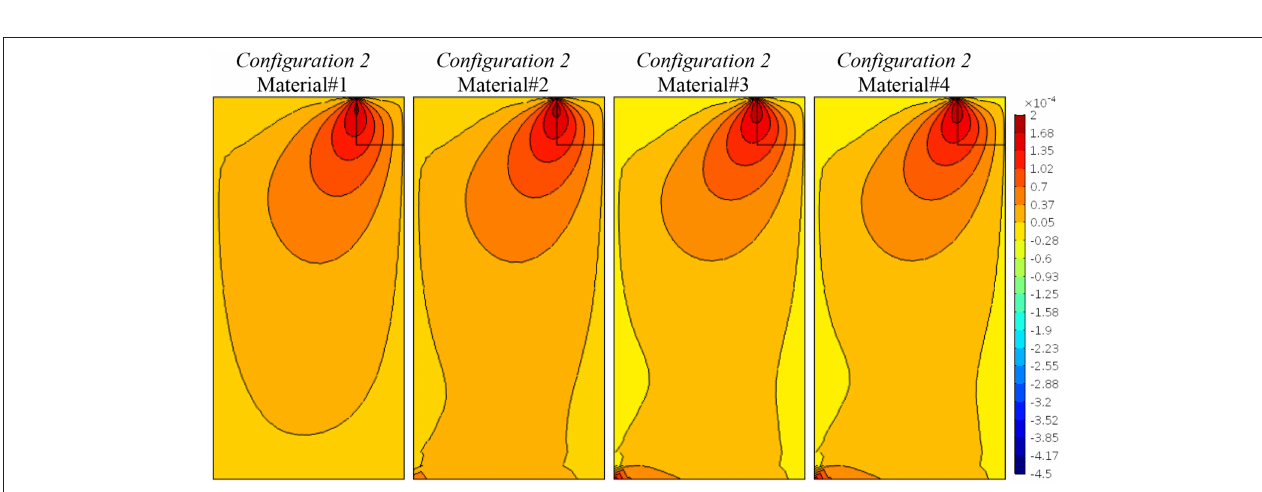
FIGURE 7 | Configuration 2, relative rotations, θ − φ , contour plots for four material cases (Material#1/Material#4 minimum/maximum anisotropy